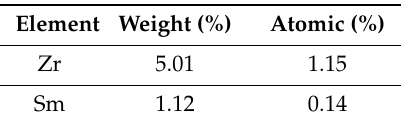
Table 5. Quantitative EDS analysis results obtained from point 1 on the surface of the sample presented in Figure 8b (data only for Zr and Sm).